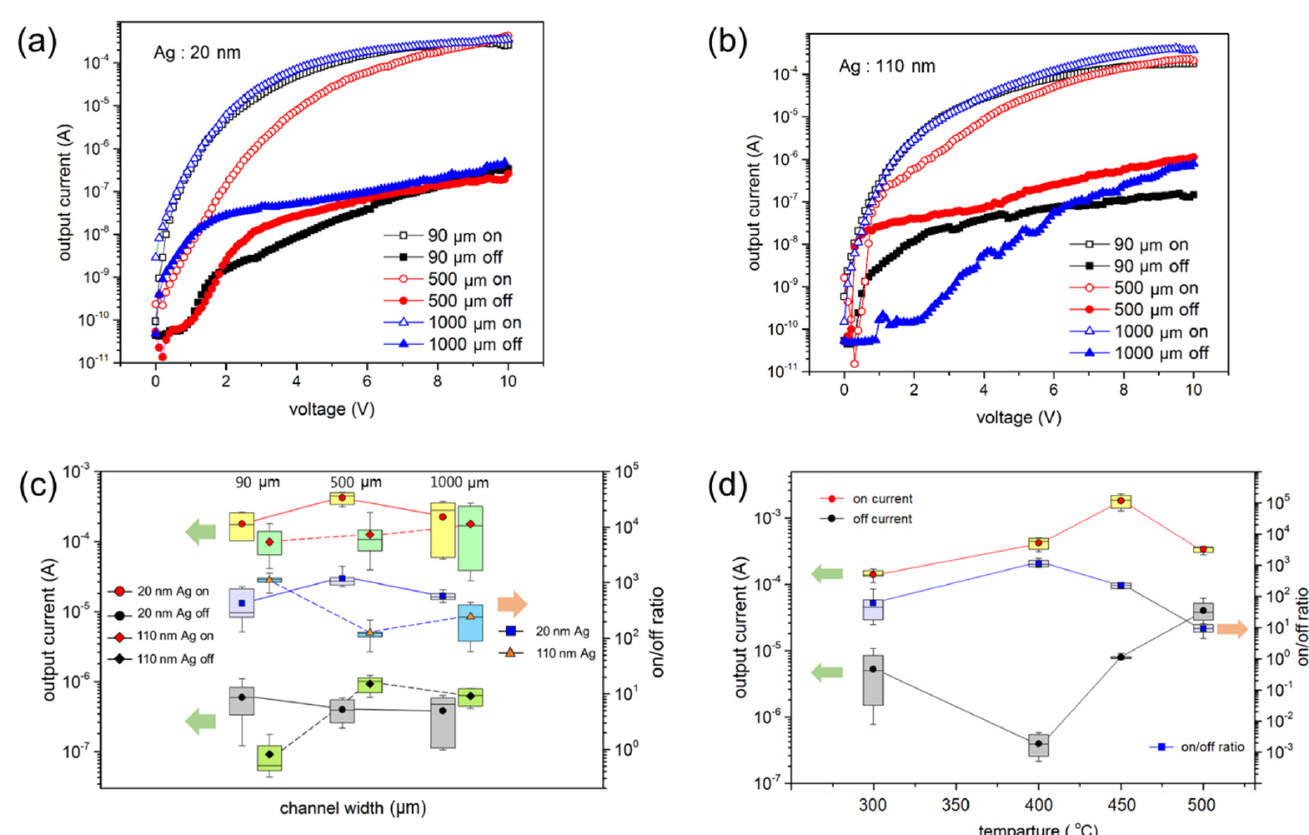
Figure 3. Output characteristics (output current vs. sample bias voltage) of the bottom − mode pho- todetecting devices under various fabricating conditions: ( a ) 20 nm and ( b ) 110 nm Ag films annealed at 400 °C with various electrode channel widths (90, 500, and 1000 μ m). Output currents were measured under visible light illumination with an intensity of 14.1 mW/cm 2 (on) and 0.0 mW/cm 2 (off). ( c ) Output currents and on/off ratios of bottom − mode devices in ( a , b ) at a bias voltage of 10 V. ( d ) Output currents and on/off ratios at a bias voltage of 10 V of the bottom − mode devices with a 500 µ m electrode channel width and 20 nm Ag film thickness annealed at various temperatures (300, 400, 450, and 500 °C).